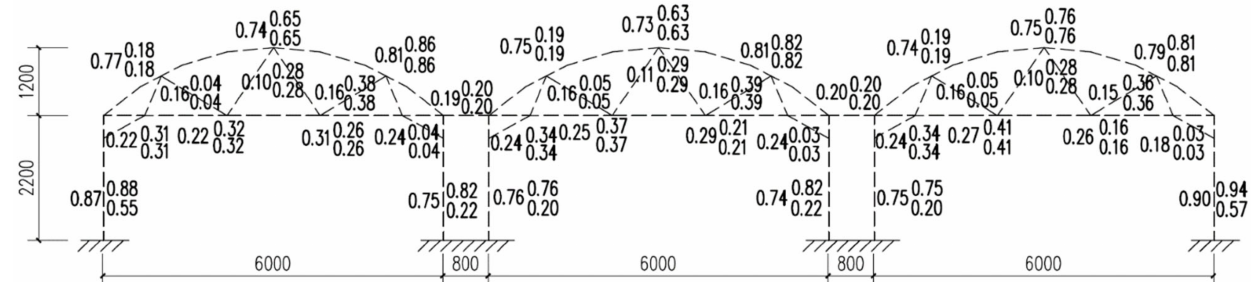
Figure 9. Stress ratios of structural calculation (unit: mm). Notes: the number on the left of each component is the strength stress ratio, that on the upper right is the in-plane stability stress ratio, and that on the lower right is the out-of-plane stability stress ratio.